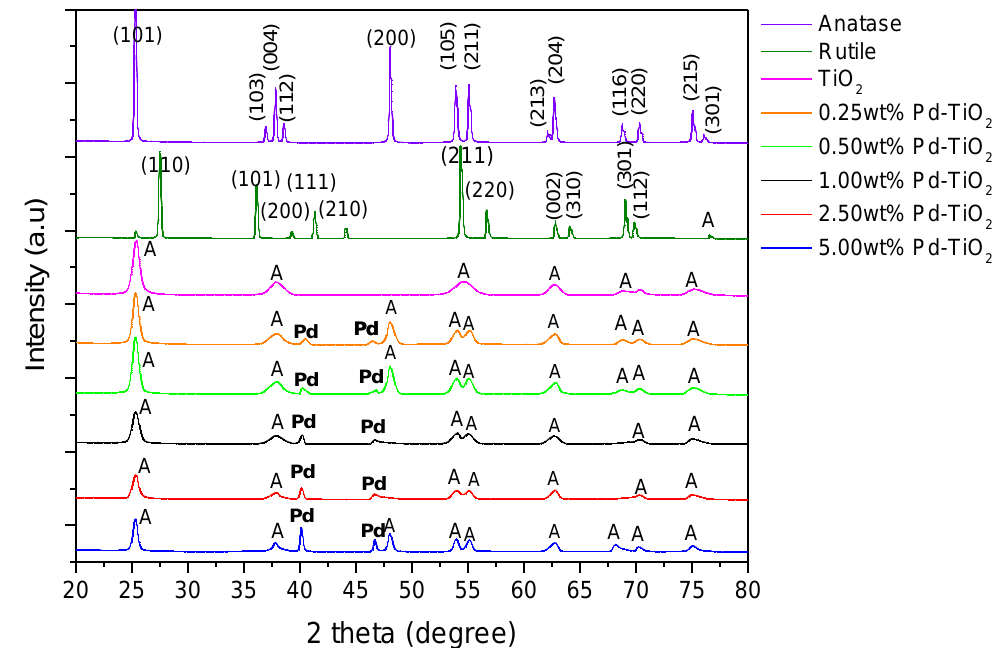
Figure 1. X-ray diffraction (XRD) diffractograms of photocatalyst doped with Pd. XRDs overlapped for comparison. A = anatase, Pd = palladium.